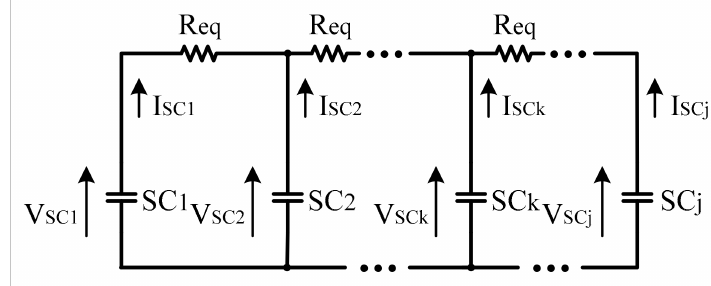
Figure 6. Model of the ZCS mode